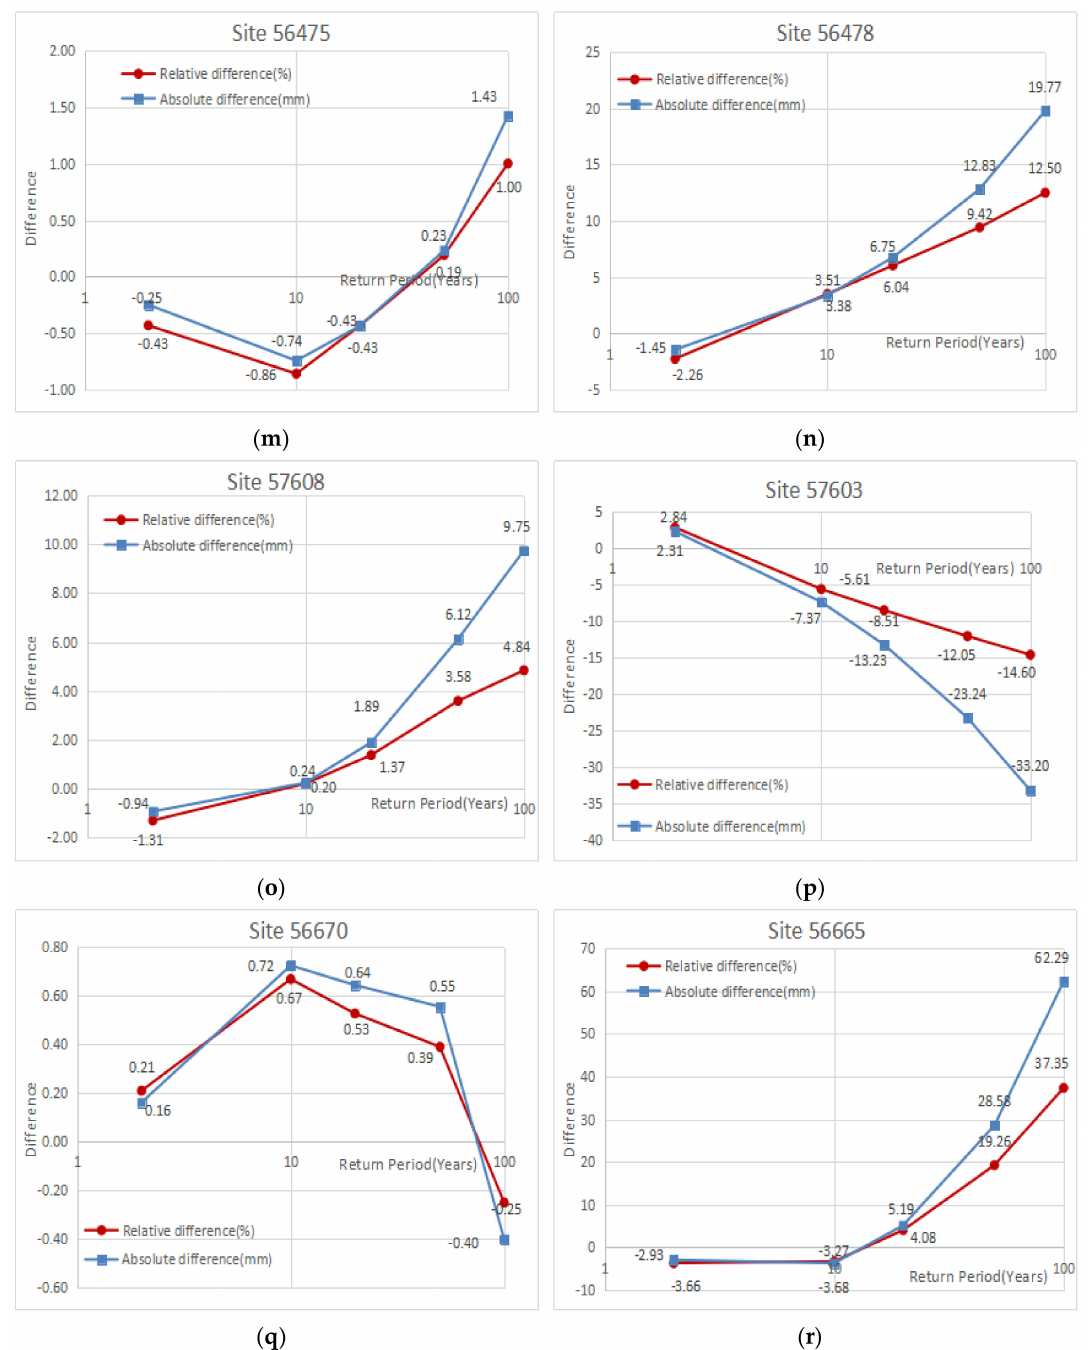
Figure 3. ( a – r ) are the results of the differences of rainfall design values under different return periods obtained by using regional frequency analysis and traditional at-site hydrological frequency analysis of 18 representative stations. (RFA: regional frequency analysis; At-site: traditional at-site hydrological frequency analysis; Absolute difference: the rainfall design value obtained by At-site minus the corresponding result obtained by RFA; Relative difference: the Absolute difference relative to the corresponding result obtained using